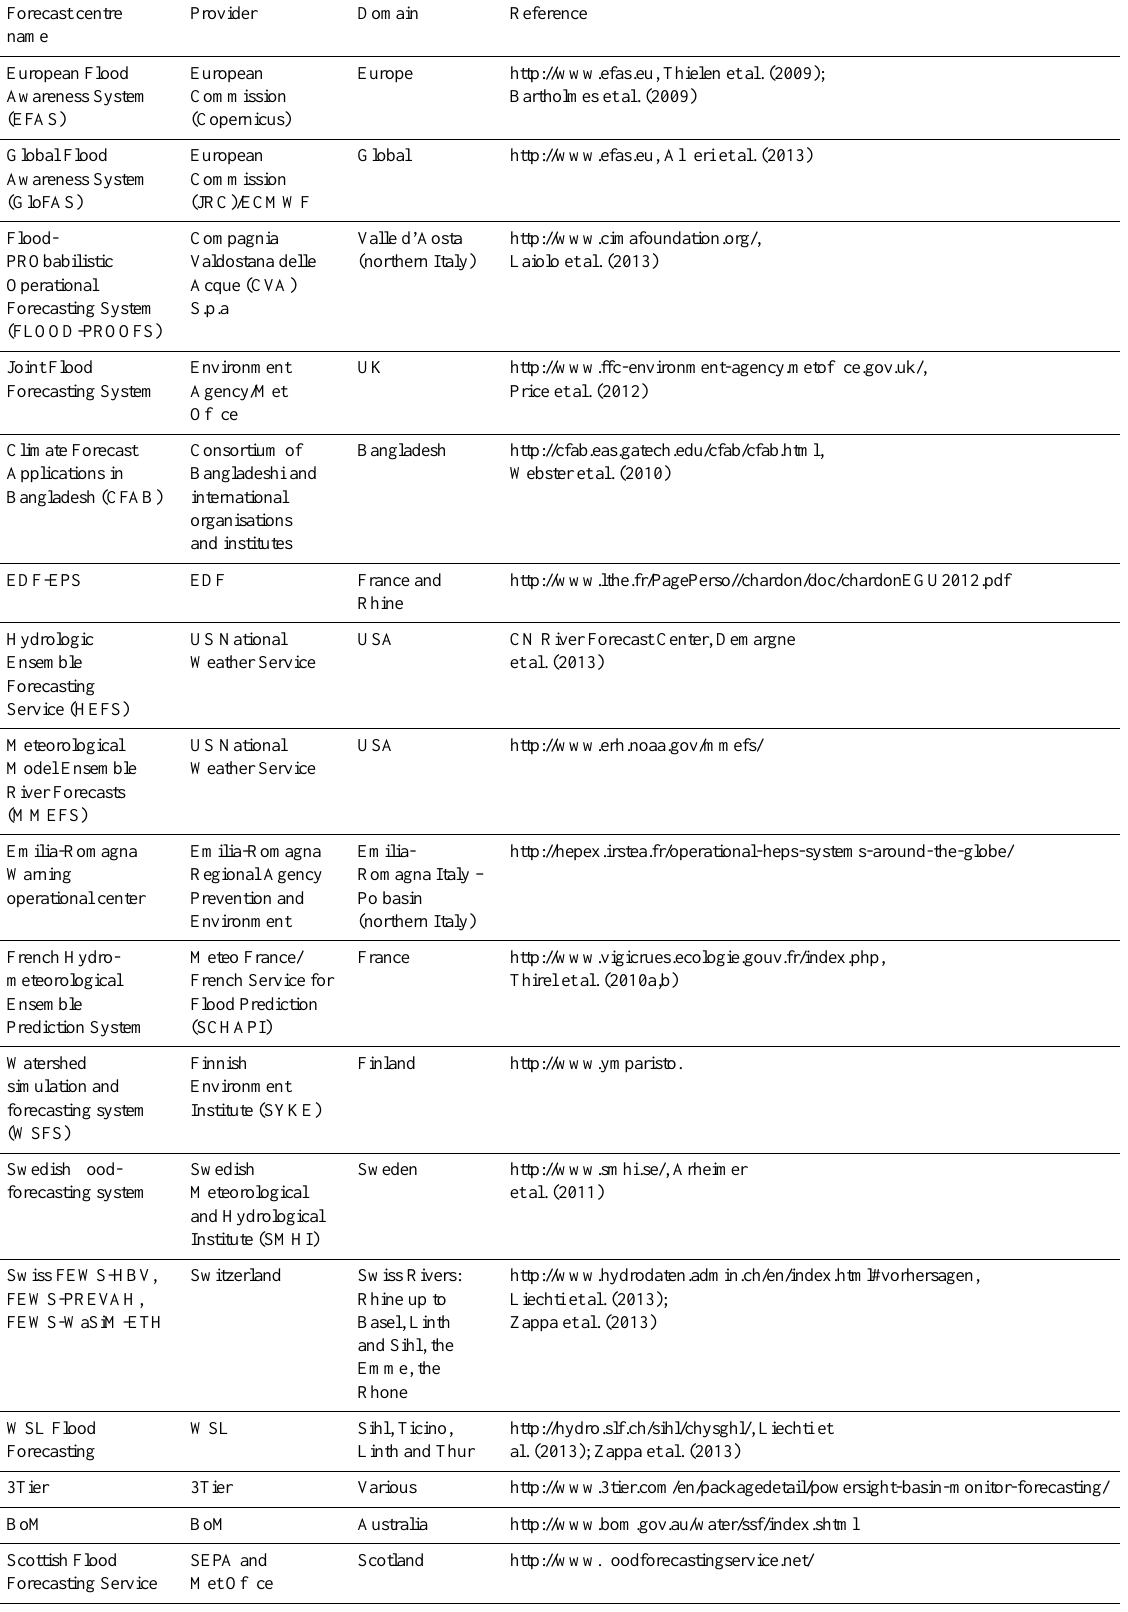
Table 1. Forecast centres with operational or pre-operational HEPS. Forecast